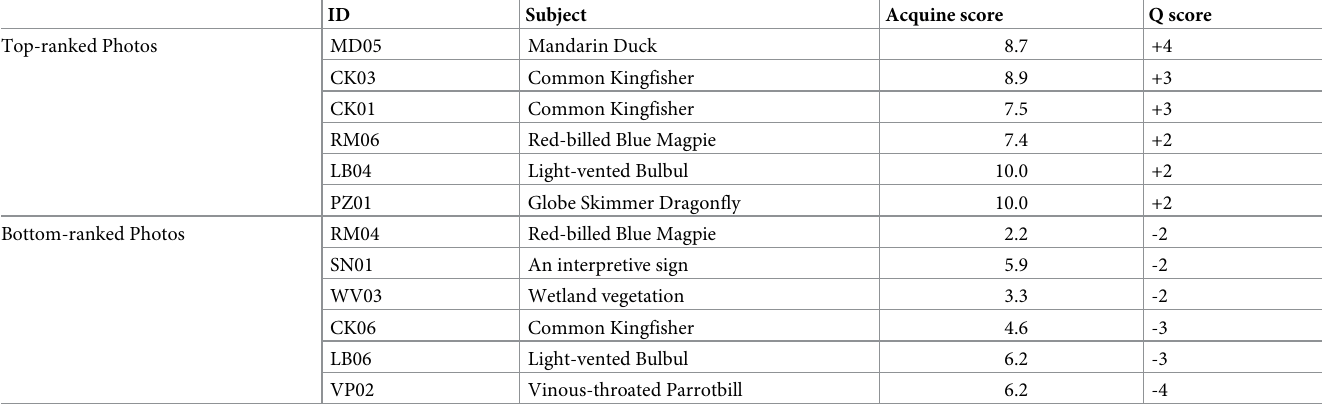
Table 3. The six top-ranked and six bottom-ranked photographs for Factor